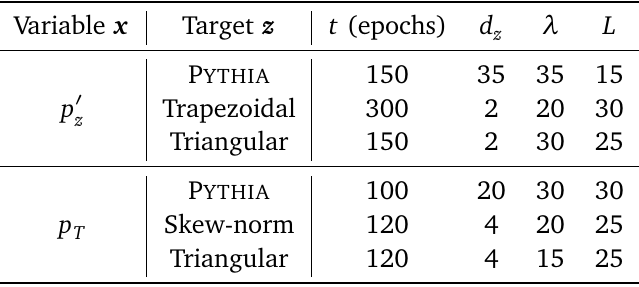
the dimension of the latent z